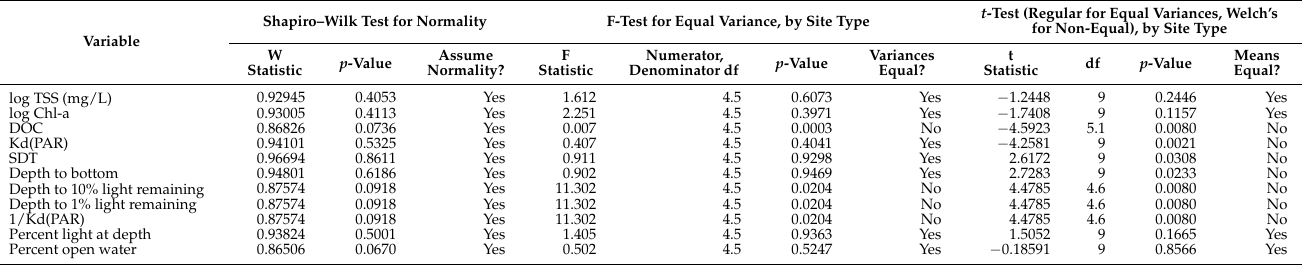
Table 4. Statistical test results for establishing whether means are equal by site type for each